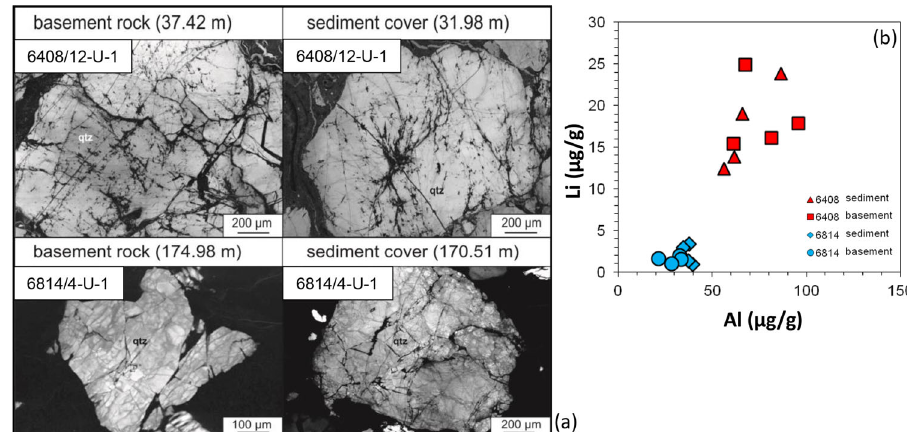
Fig. 9 Provenance assessment of weathered basement. a SEM-CL images of quartz grains from the weathered basement and early Jurassic sediment cover in well 6408/12-U-01 and 6814/4-U-01. Note the similarities of the grains suggesting that the Mesozoic sediment cover are derived locally from a weathered basement. b Concentration of Al versus Li (in µ gg − 1 ) of quartz grains in the weathered basement and overlying Mesozoic sediments in wells 6814/4-U-01 and 6408/12-U-01. Note the correspondence between the weathered basement and overlying Mesozoic sediment cover in both